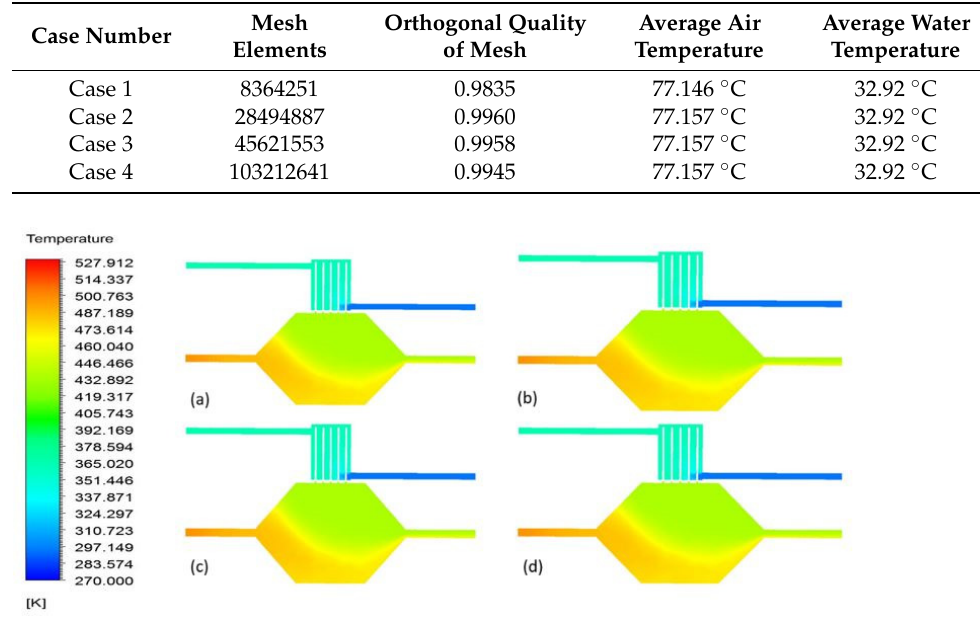
Figure 3. The average temperature for input air temperature 150 ◦ C and 30 ◦ C water inlet temperature with ( a ) 0.8 million ( b ) 2.8 million ( c ) 4.5 million and ( d ) 10.3 million elements in the